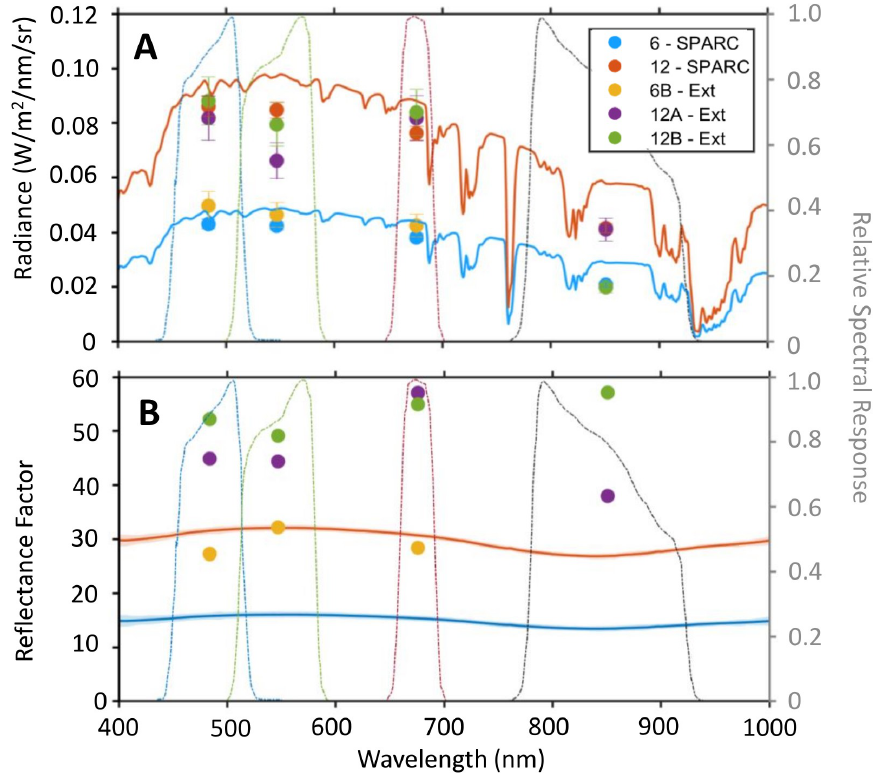
Figure 10. The Top of Atmosphere ( A ) calculated SPARC radiance (solid lines) were